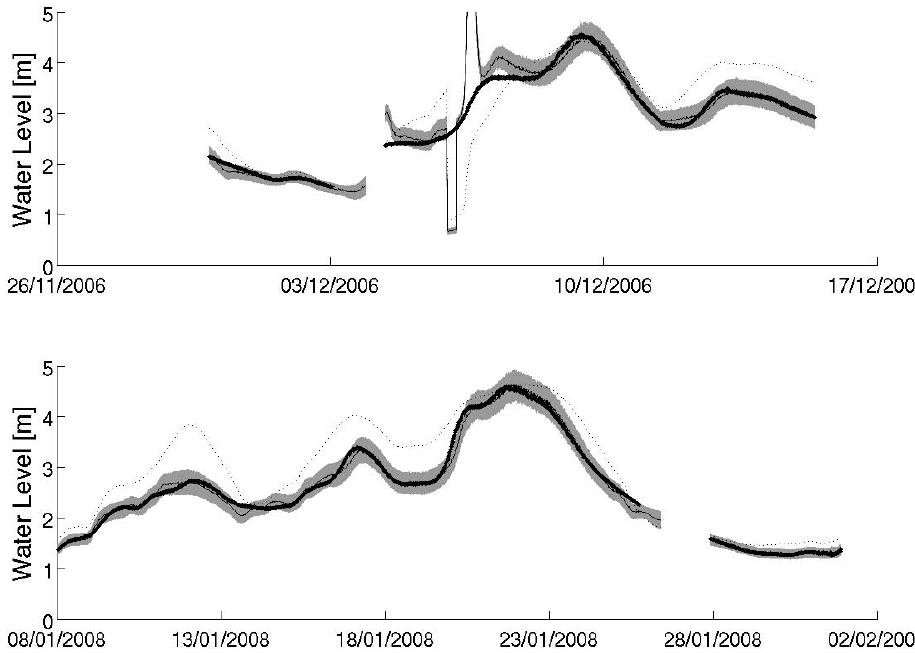
Fig. 6. Examples of 6h ahead forecasts given at Welsh bridge for two large flood events during calibration (upper pane) and validation (lower pane) periods generated using the RW model calibrated using the SEFE methodology. The shaded area represents the 95% prediction confidence interval with the solid line being the expected value of the predictions. Observed data points are also shown along with the deterministic model forecast (dotted